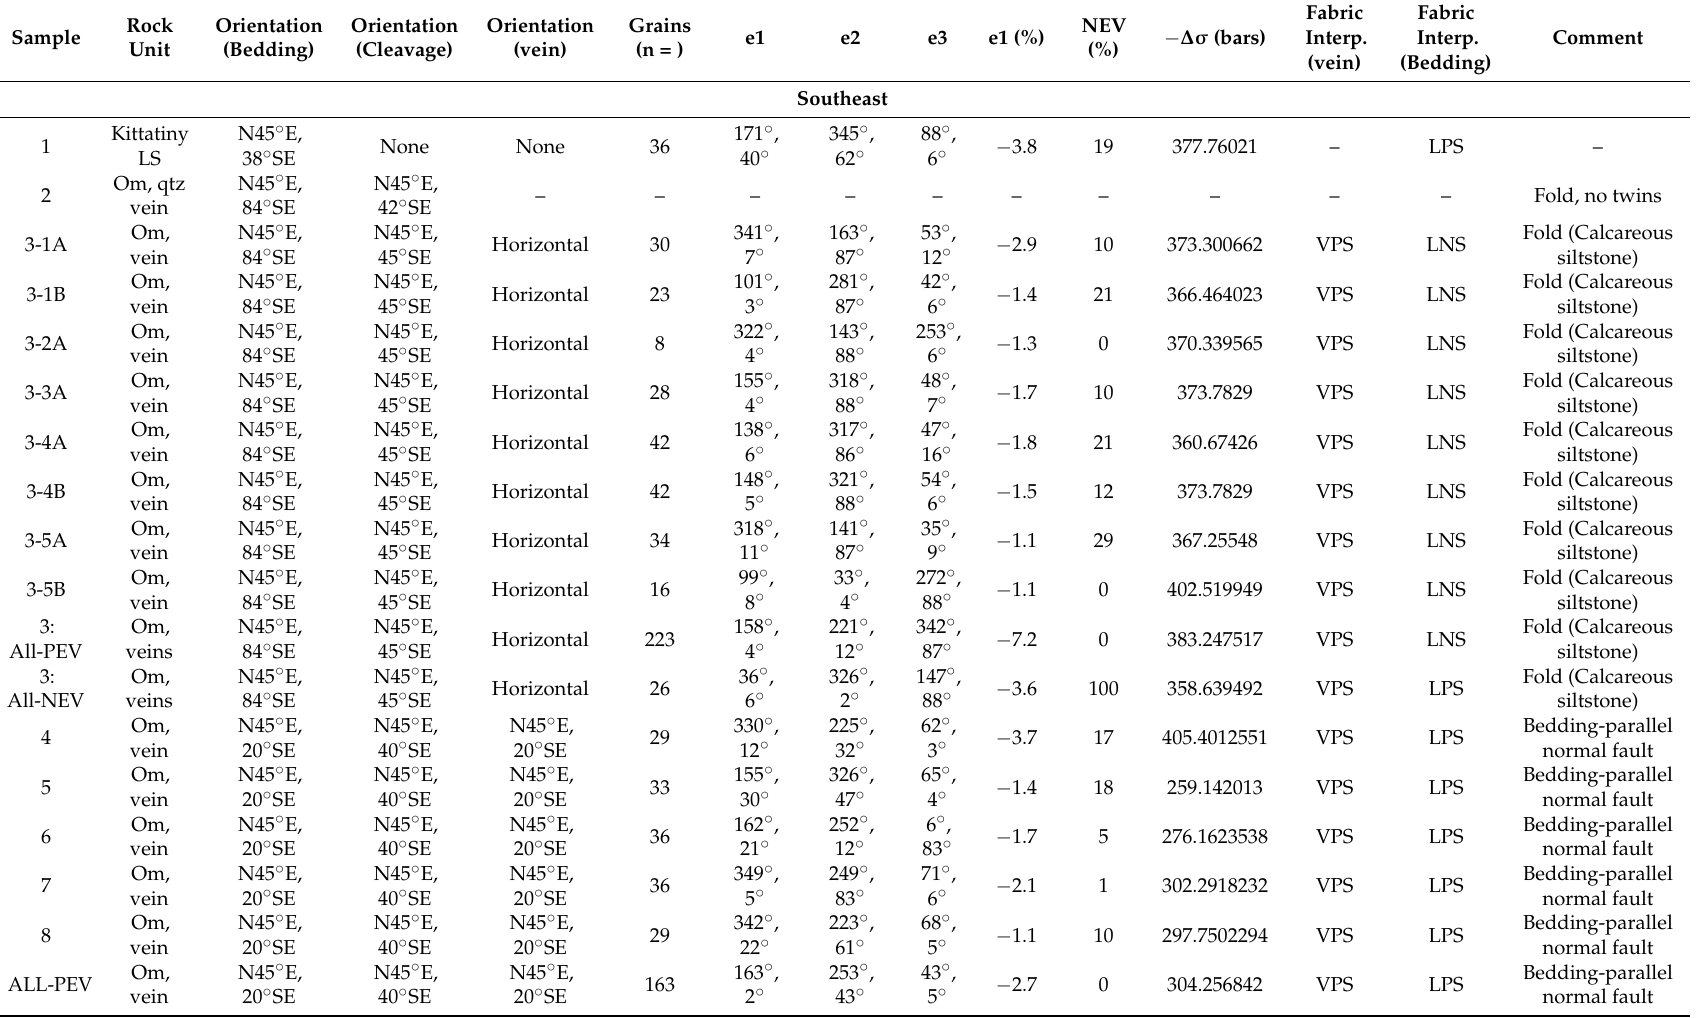
Table 2. Martinsburg Fm. Cleavage-Clastic Dike Calcite Twinning Strain